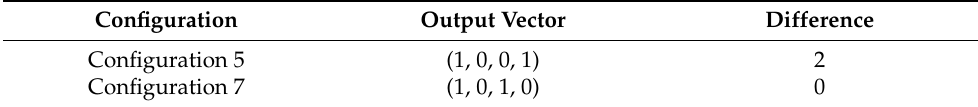
Table 6. The value of the fitness function for Configuration 5 and Configuration 7. Configuration